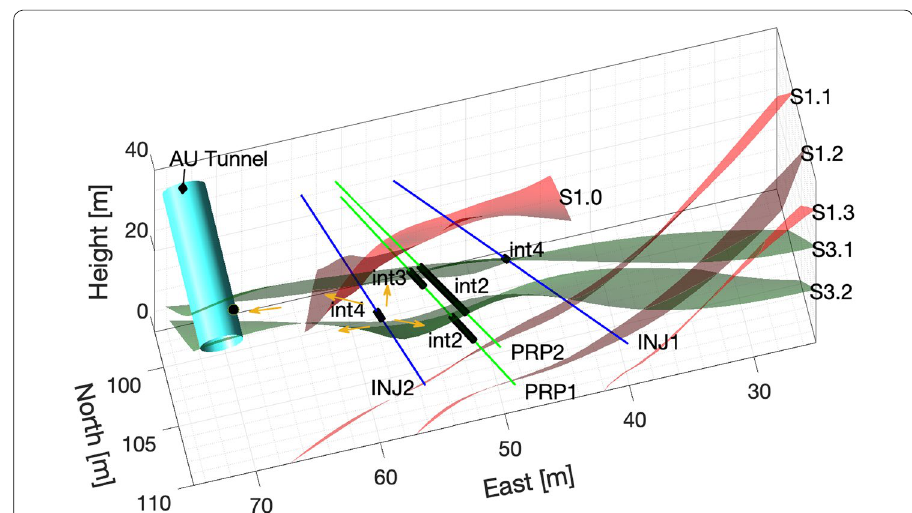
Fig. 1 Overview of the experiment setup at the Grimsel Test Site (GTS) (modified from Krietsch et al. 2018). The shear zone structures, designated S1 and S3, are shown as red and green planes, respectively. There is also a shear zone classified as S2, which is slightly discordant to S1. However, the S1 and S2 shear zones cannot be distinguished in the field (Keusen et al. 1989; Krietsch et al. 2018). The injection and monitoring intervals, associated with this study, in boreholes INJ1, INJ2, PRP1, and PRP2 (black cylinders) and the AU Tunnel outflow point (black circle) are marked. The orange arrows indicate the interpreted flow directions in injection interval INJ2‑int4, where the arrows with solid lines are associated with the more prominent flow directions (see Section ’Redistribution of fluid flow’ for more